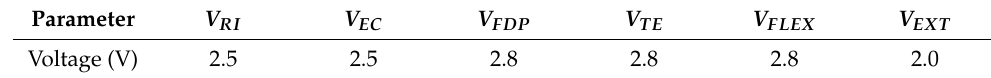
Table 2. Potential that we used in the experiments.